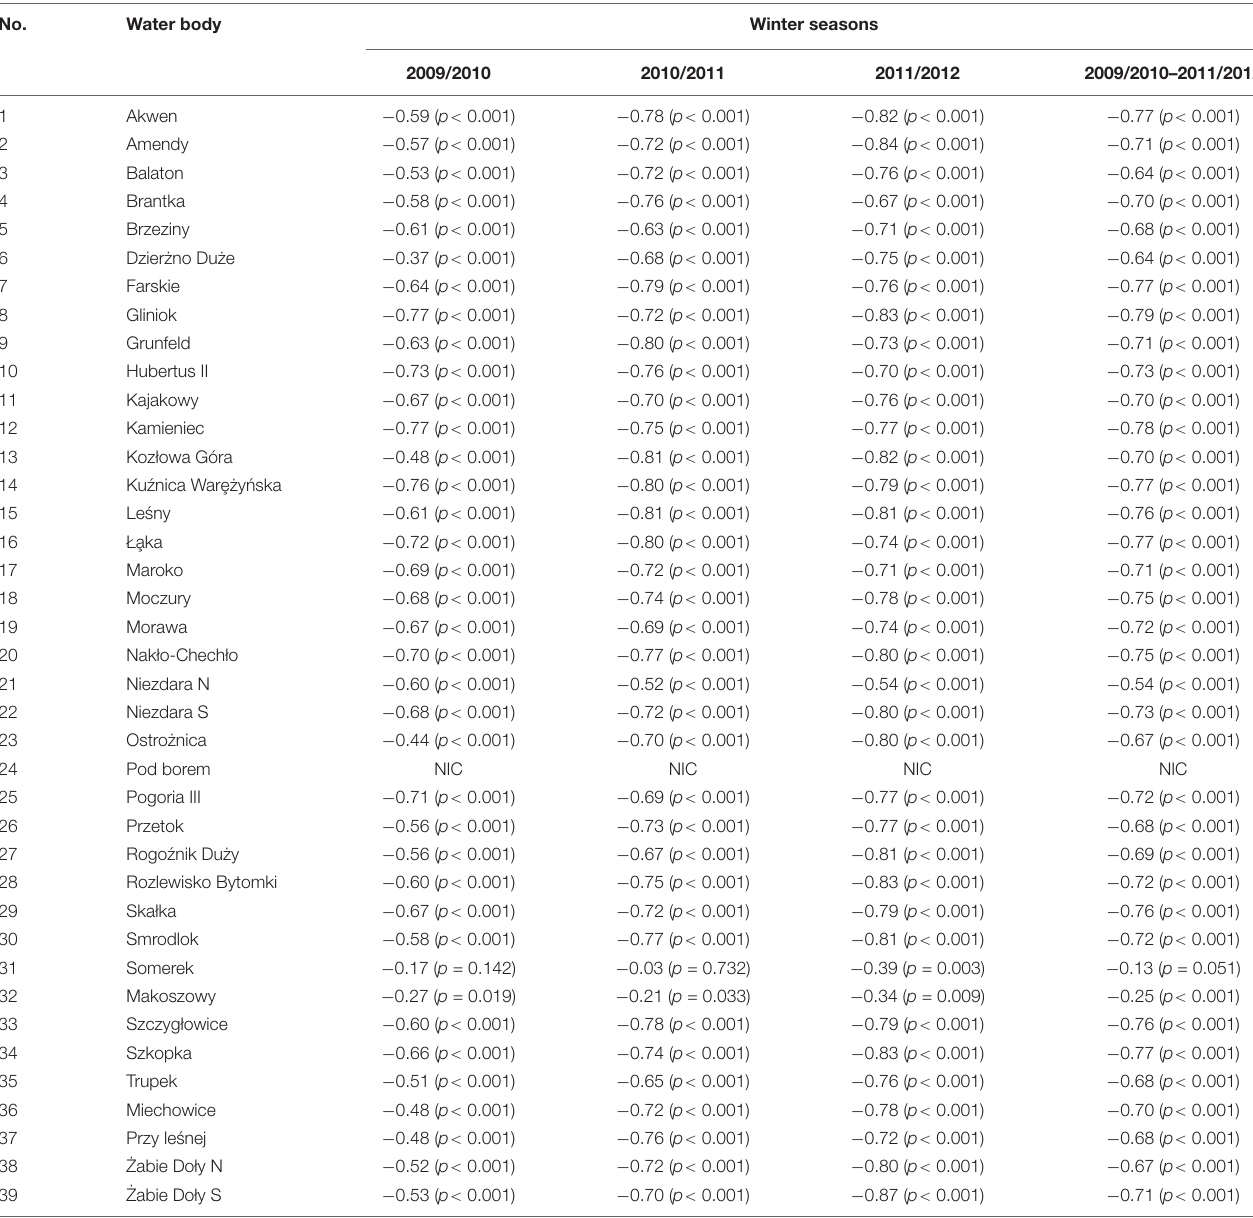
TABLE 3 | Values of Spearman’s correlation coefficients between the daily changes in average air temperature at Sosnowiec meteorological station and daily changes in ice thickness.